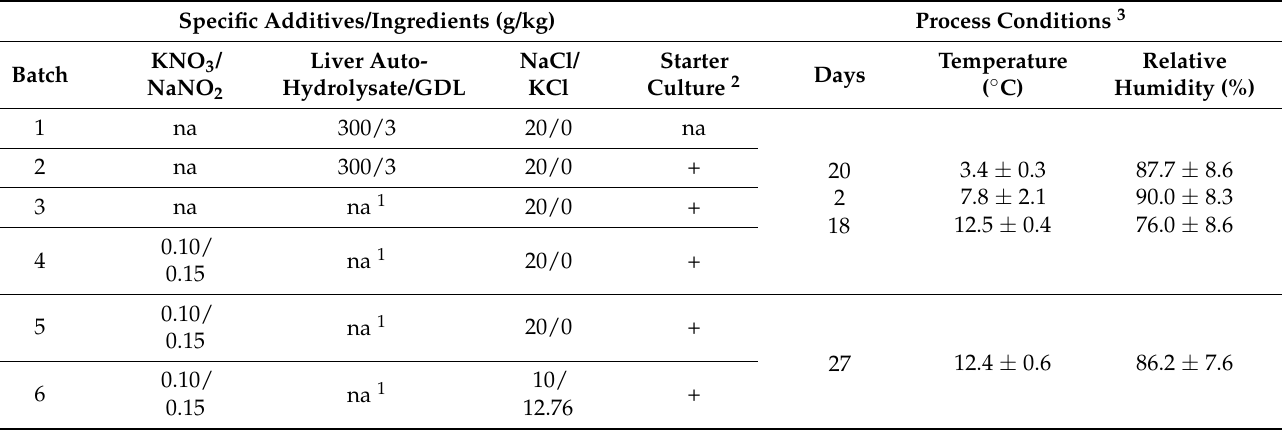
Table 1. Assessed dry fermented sausage formulations and process